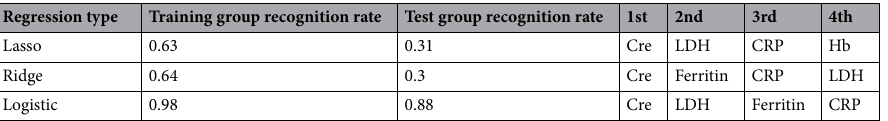
Table 2. Accuracy of the three evaluation models and comparison of the influence of each factor in each regression model from greatest to least. Cre, creatine; CRP, C-reactive protein; Hb, hemoglobin; LDH, lactate